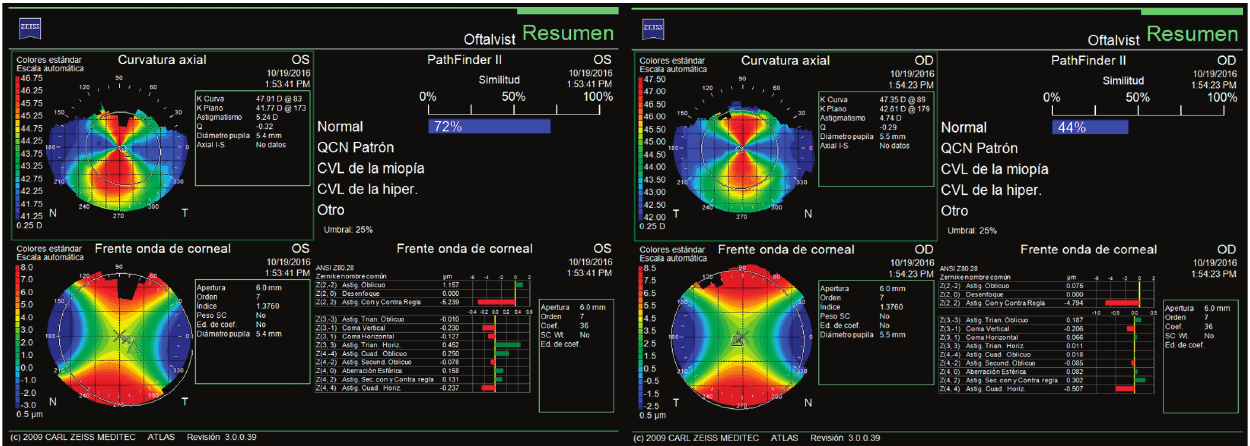
Figure 3. Atlas corneal topography (top) and Oculus Pentacam HD (bottom) maps of both eyes of the patient.